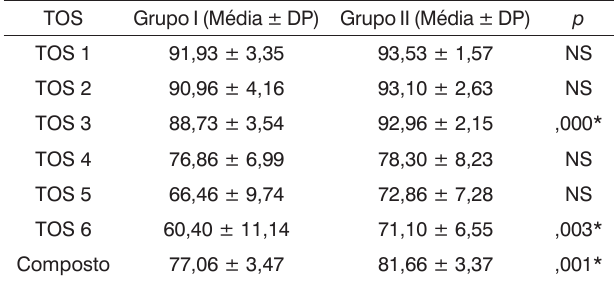
Tabela 1. Dados TOS dos